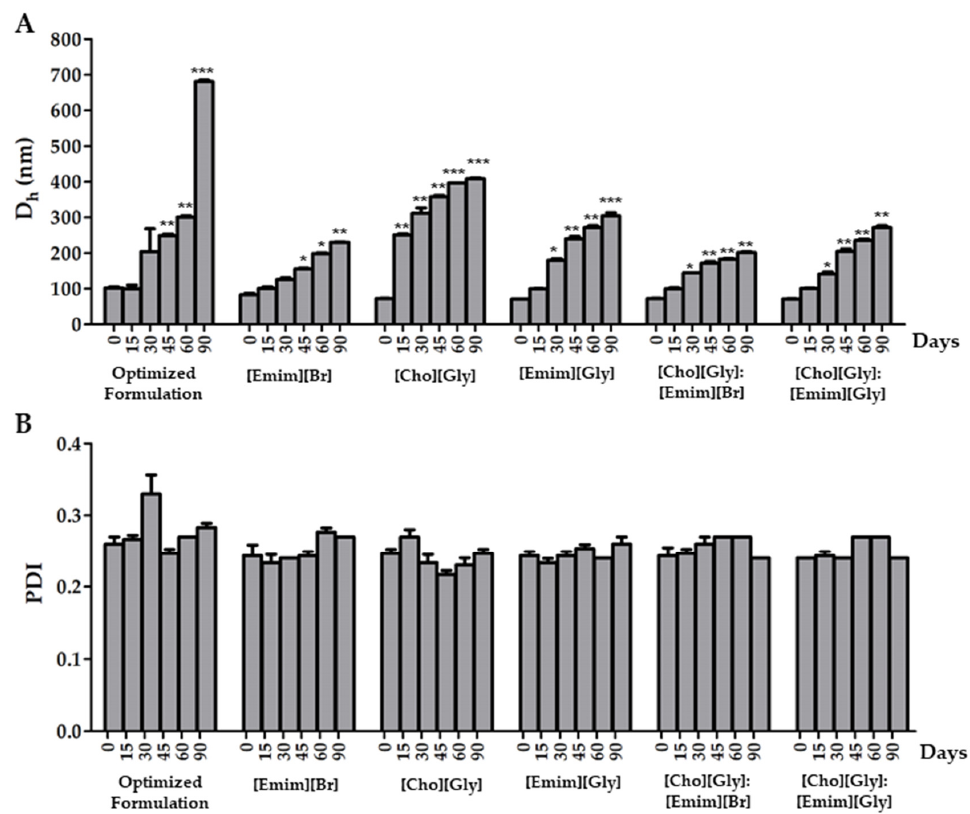
Figure 4. Variation of the hydrodynamic diameter (D h ) ( A ) and the polydispersity index (PDI) ( B ) of rutin-loaded transfersomes in the absence (optimized formulation) or in the presence of each IL, or of their combinations, upon refrigerated (5 ± 2 °C) storage for 90 days. Mean ± SD, n = 3, * p < 0.05, ** p < 0.01, and *** p < 0.001.